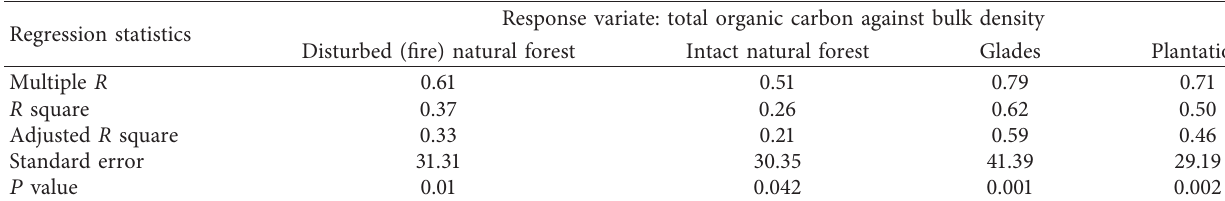
Table 3: Regression statistics: linear